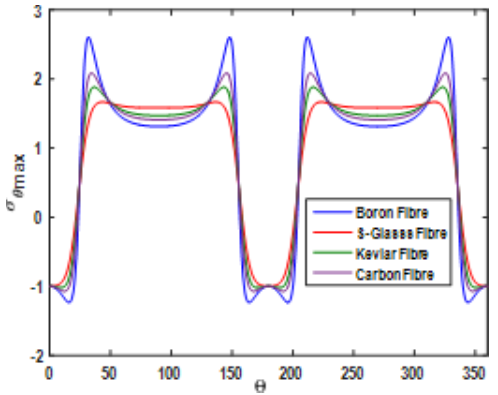
( σ ∞ x = 1 , [45 / − 45]s) θ